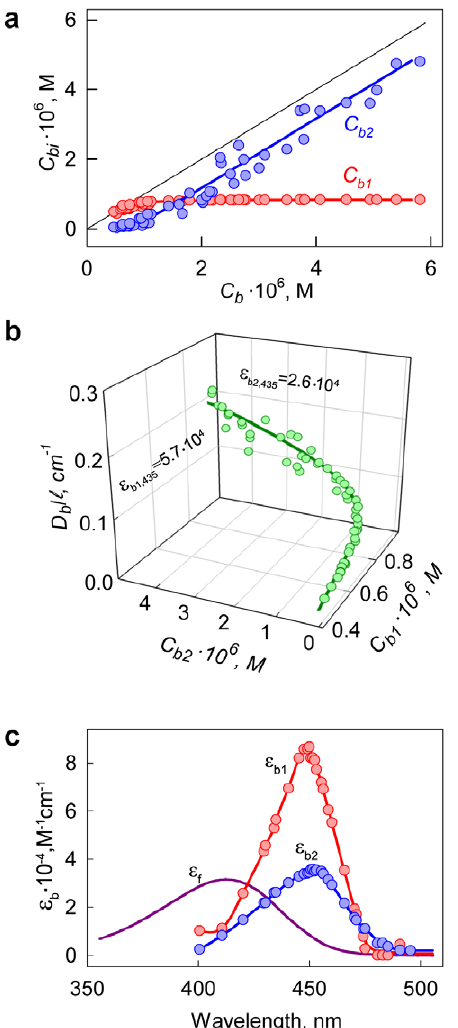
Figure 3. Determination of the molar extinction coefficient of thioflavine T (ThT) bound to insulin amyloid fibril. (a) Concentration of ThT, bound with amyloid fibril ( C b ), as superposition of the dye concentrations bound to mode 1 ( C b1 ) and mode 2 ( C b2 ). (b) The dependence D b = D b1 + D b2 = e b1 C b1 l + e b2 C b2 l . In the panel experimental data, best fit curve and the values of molar extinction coefficients e b1 and e b2 obtained by multiple nonlinear regression are presented. (c) Absorption spectra of ThT, bound to mode 1 and mode 2 in the units of the molar extinction coefficient.